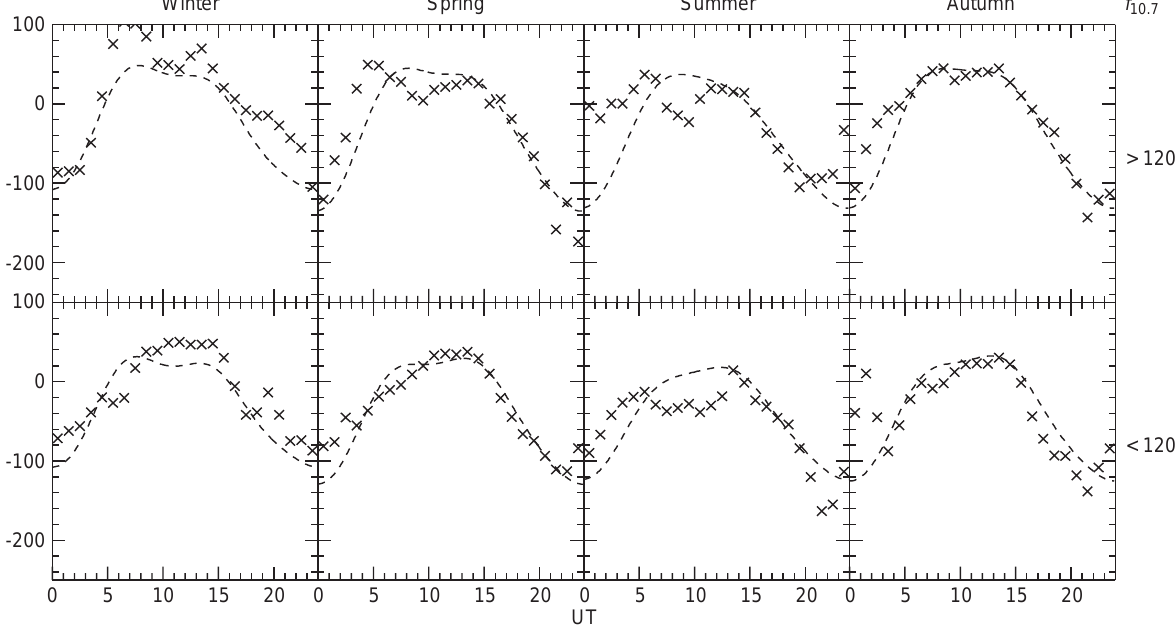
Fig. 8. Comparisons between the mean wind ( crosses ) at 185 km height and the HWM model ( dashed line